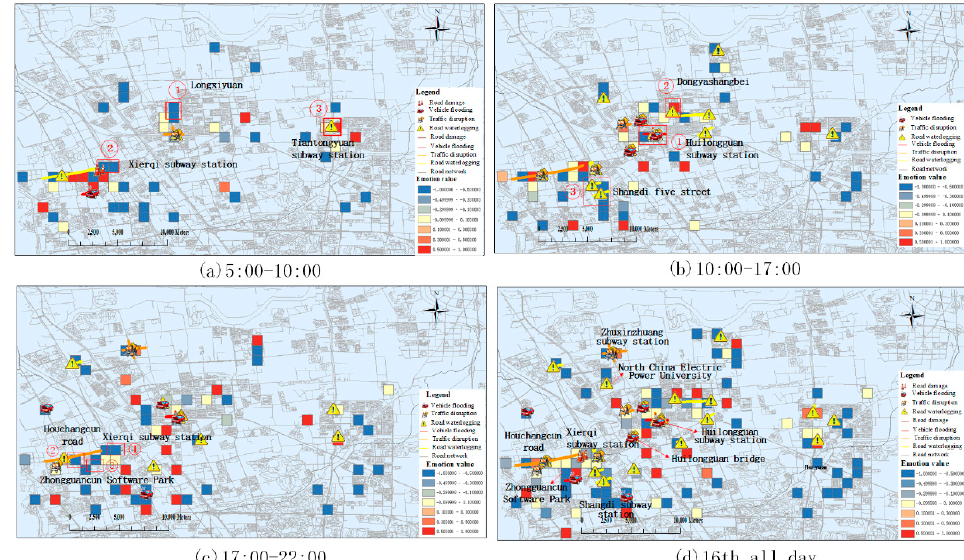
Figure 4. Evolution process of the disaster information distribution on the 16th. The figure (a), (b), (c) and (d) describe the disaster information in different time periods on July 16th. Among them, the time period described in figure (a) is the morning peak, figure (c) is the evening peak, figure (b) is the other periods, and figure (d) is the whole day on the 16th. The red circles in each figure are regions of interest which will be further studied in detail.